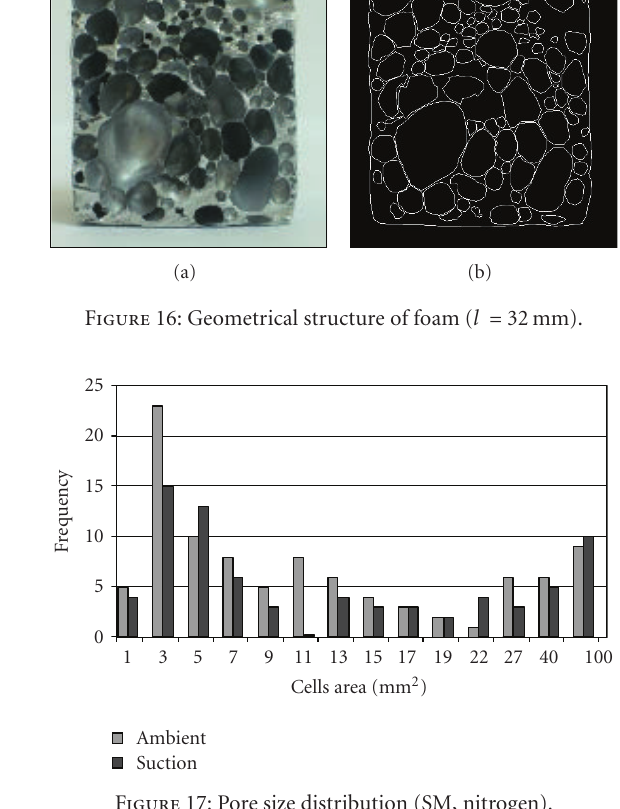
Figure 17: Pore size distribution (SM,